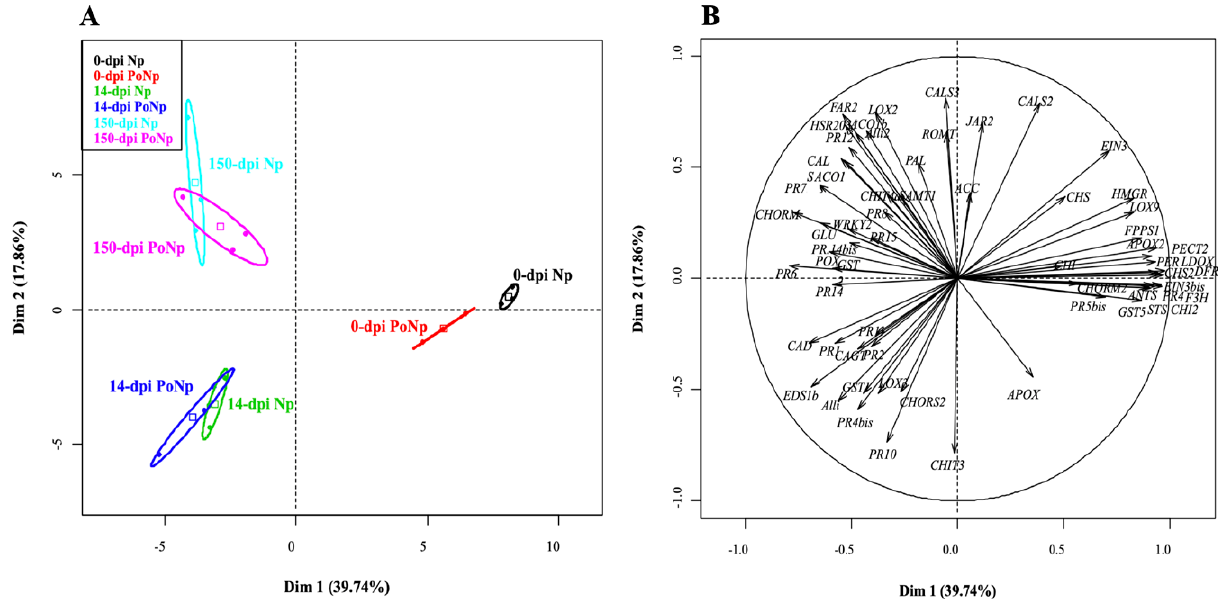
Figure 4. A. Principal component analysis of specific plant responses to Neofusicoccum parvum and Pythium oligandrum + N. parvum inoc- ulation treatments (relative expression levels of the 62 genes involved in plant defences), at 0, 14 or 150 days after inoculations at trunk level.. Ellipsoids represent the centre of factors with 95% confidence. The different groups are indicated by different colours. Np = N. par- vum , PoNp = P. oligandrum + N. parvum . B. Distribution into the correlation circles of the relative expression levels of the 62 genes